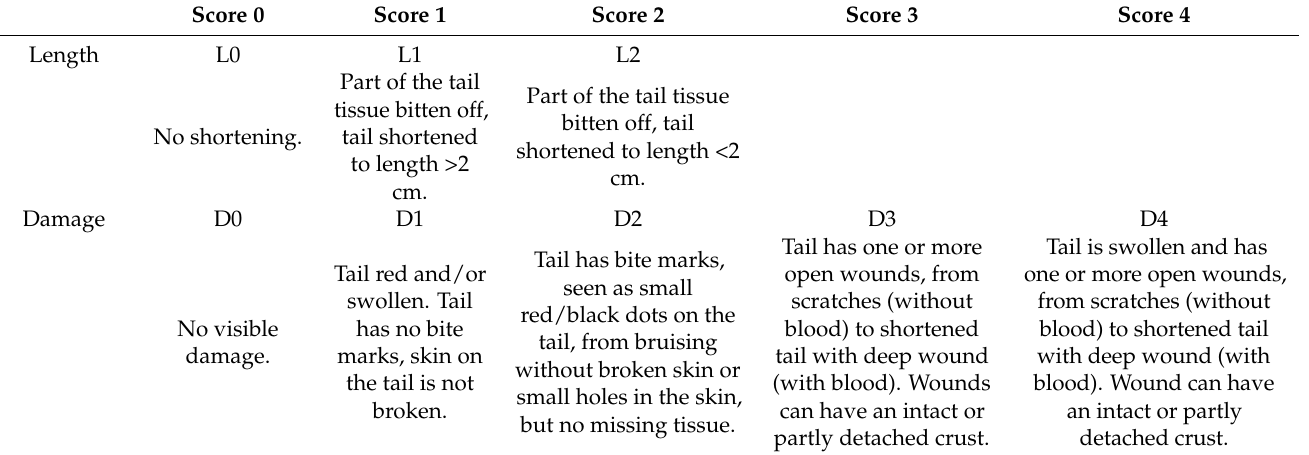
Table 2. Scoring system used to assess tail length (L0–L2) and tail damage (D0–D4)